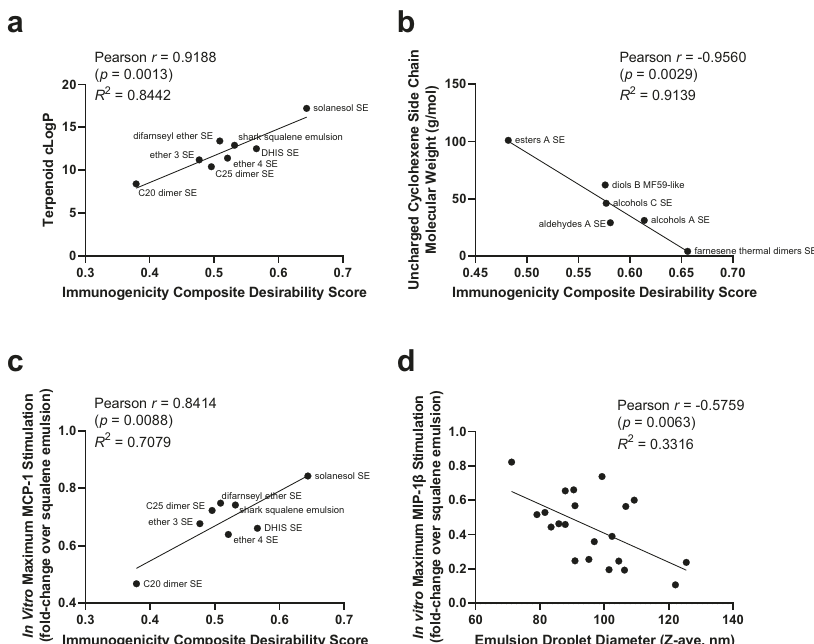
Fig. 5 Structure-function correlations. a Immunogenicity composite desirability score of linear unsaturated terpenoids correlates with terpenoid cLogP. b Side chain molecular weight of cyclohexene-containing terpenoids inversely correlates with immunogenicity composite desirability score. c In vitro human whole blood MCP-1 stimulation activity of linear unsaturated terpenoid emulsions correlates with in vivo composite desirability score. d In vitro human whole blood MIP-1 β stimulation activity of SE formulations correlates with emulsion droplet diameter. For all correlation plots, a single mean value was computed for structures that were included in more than one experiment (antigen alone, shark squalene SE/MF59-like, shark squalane/squalane SE, long-chain triglyceride SE, alcohols A SE, and solanesol SE) such that each terpenoid structure is represented only